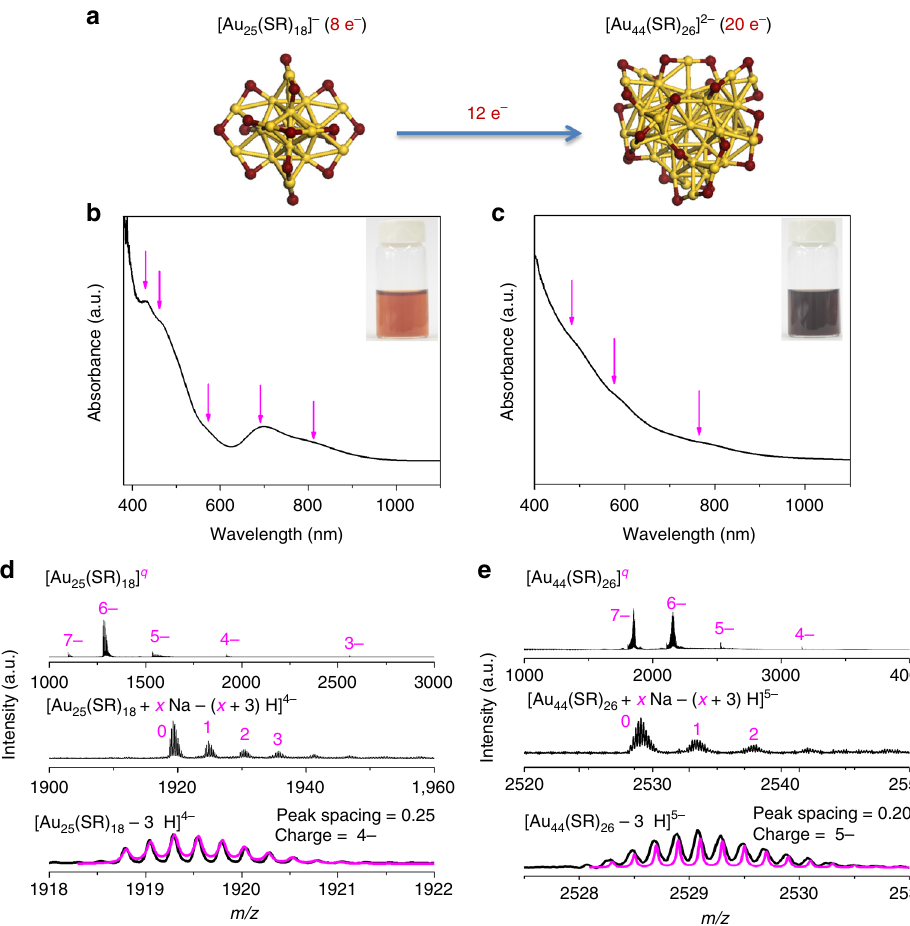
Fig. 1 Size growth from [Au 25 (SR) 18 ] − to [Au 44 (SR) 26 ] 2 − . a Schematic illustration of size growth reaction from [Au 25 (SR) 18 ] − to [Au 44 (SR) 26 ] 2 − (yellow, Au; purple, S). b , c Ultraviolet-visible absorption and d , e electrospray ionization mass spectrometry spectra of b , d [Au 25 (SR) 18 ] − and c , e [Au 44 (SR) 26 ] 2 − . The crystal structures of [Au 25 (SR) 18 ] − and [Au 44 (SR) 26 ] 2 − are drawn according to the reported Au 25 S 18 10 and Au 44 S 26 15 skeletons, where all hydrocarbon tails are omitted for clarity. Insets in b , c are digital photos of aqueous solutions of corresponding Au nanoclusters. The magenta lines in d , e show simulated isotope patterns of the labeled cluster